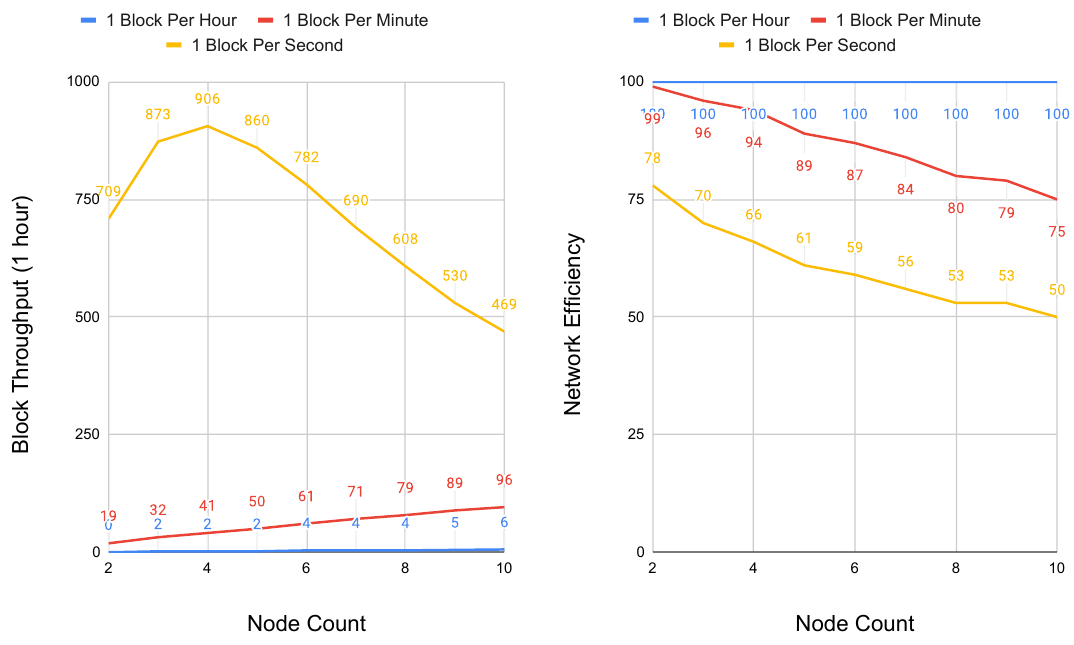
Figure 7. Performance and scalability of Conte at 15,000 km node distances and maximum hops to graph edge of 10. Block Throughput ( left ) and Network Efficiency ( right